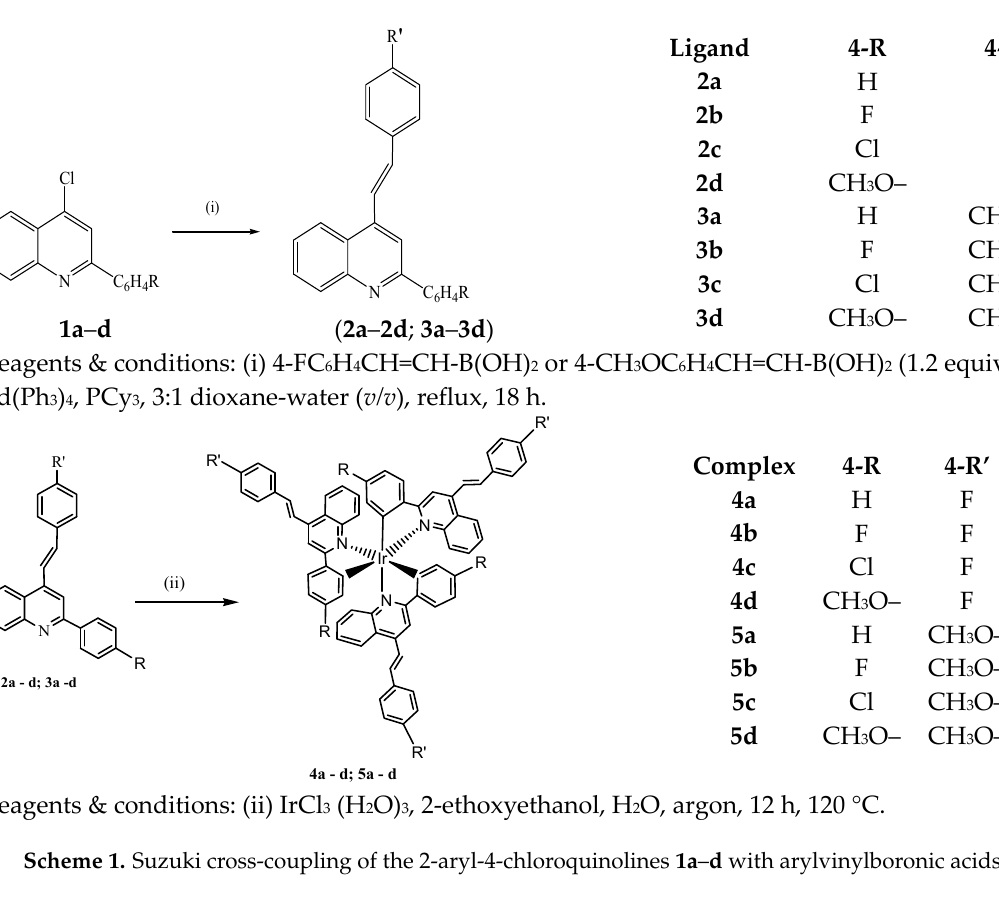
Table 1. Selected bond lengths (Ir–N and Ir–C) in Å of complex 4a and their comparison with literature values.